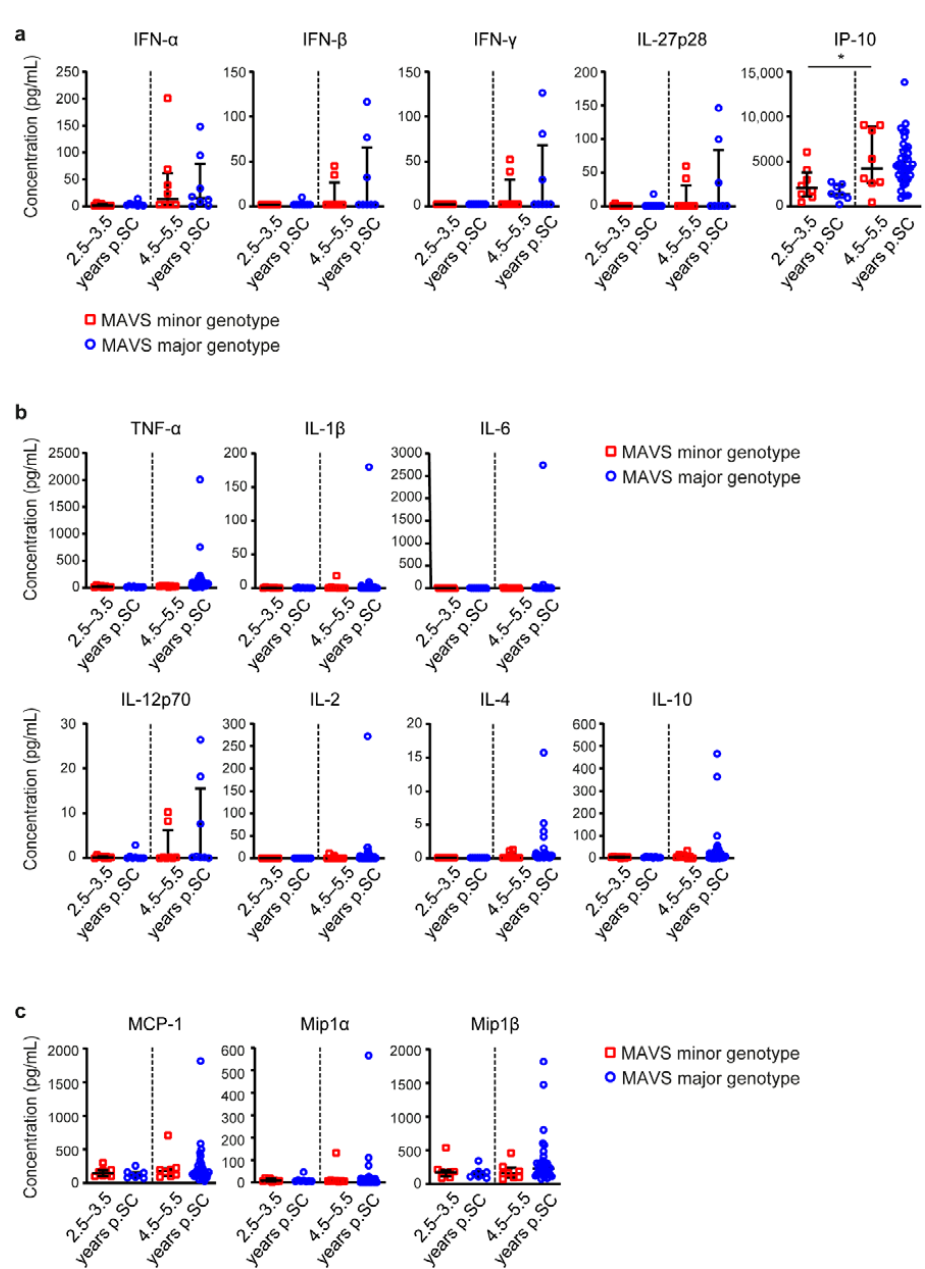
Figure 2. MAVS genetic variation does not a ff ect immune activation levels. ( a ) Concentrations of interferon (IFN) and IFN-induced molecules in serum samples obtained 2.5–3.5 and 4.5–5.5 years p.SC of untreated HIV-1-infected individuals containing MAVS minor or MAVS major genotype were measured using a multiplex assay. ( b ) Concentrations of pro-inflammatory, regulatory, and anti-inflammatory molecules and ( c ) chemokines in serum samples obtained 2.5–3.5 and 4.5–5.5 years p.SC of untreated HIV-1-infected individuals containing MAVS minor or MAVS major genotype were measured using a multiplex assay. Each square or dot represents a di ff erent study participant (median ± IQR.). All significant di ff erences are indicated: * p < 0.05, paired Wilcoxon